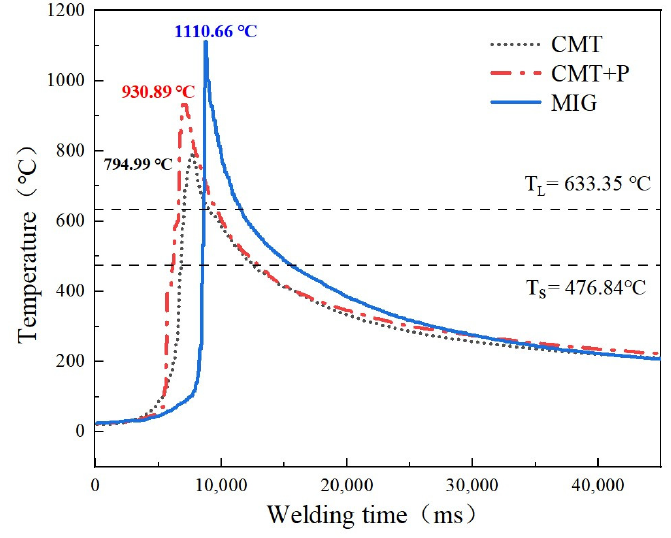
Figure 6. Temperature cycle of the welding pool (AA7075 workpiece with 7150 filler wire).